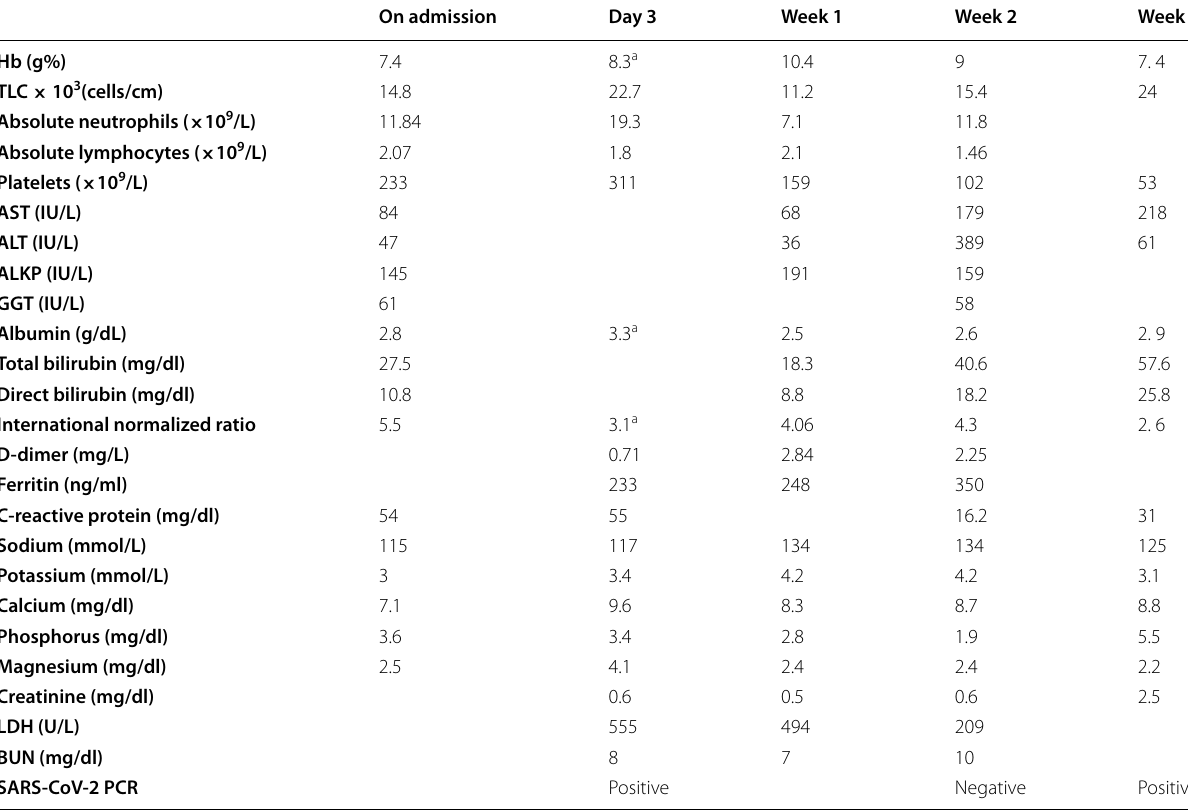
Table 1 Laboratory parameters of the patient on admission and during